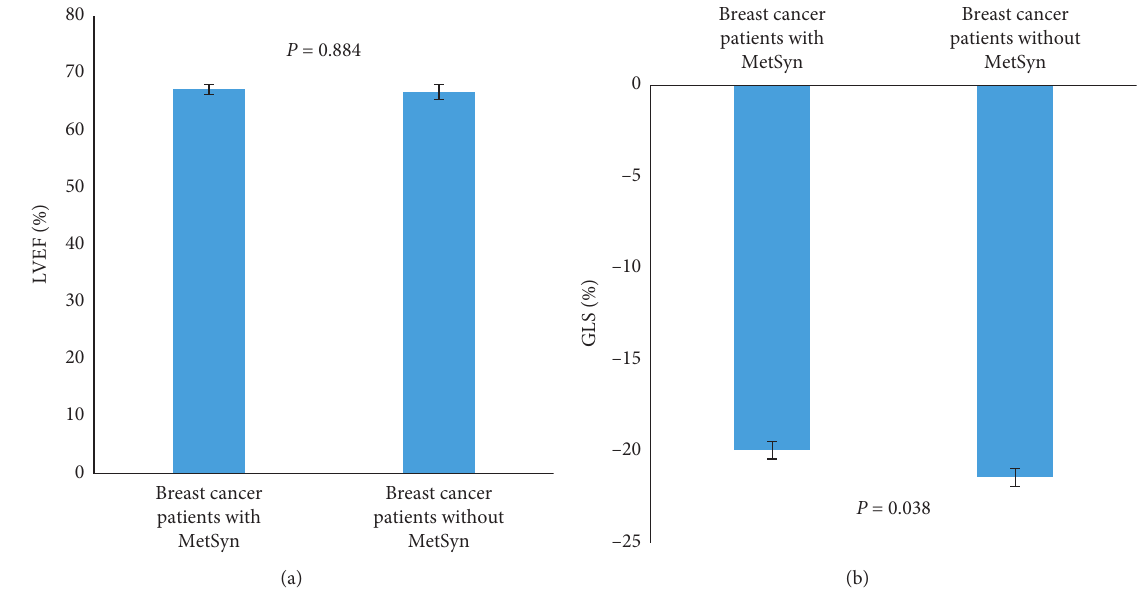
Figure 2: LVEF (a) and GLS (b) in breast cancer patients with metabolic syndrome (MetSyn) and breast cancer patients without metabolic syndrome (MetSyn) after cancer-related